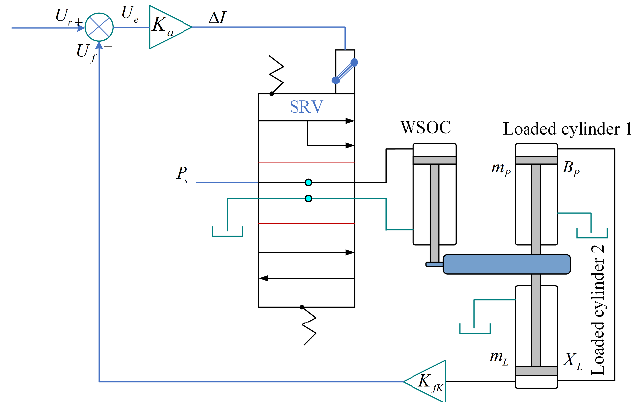
Figure 2. Schematic diagram of the EHS control system.